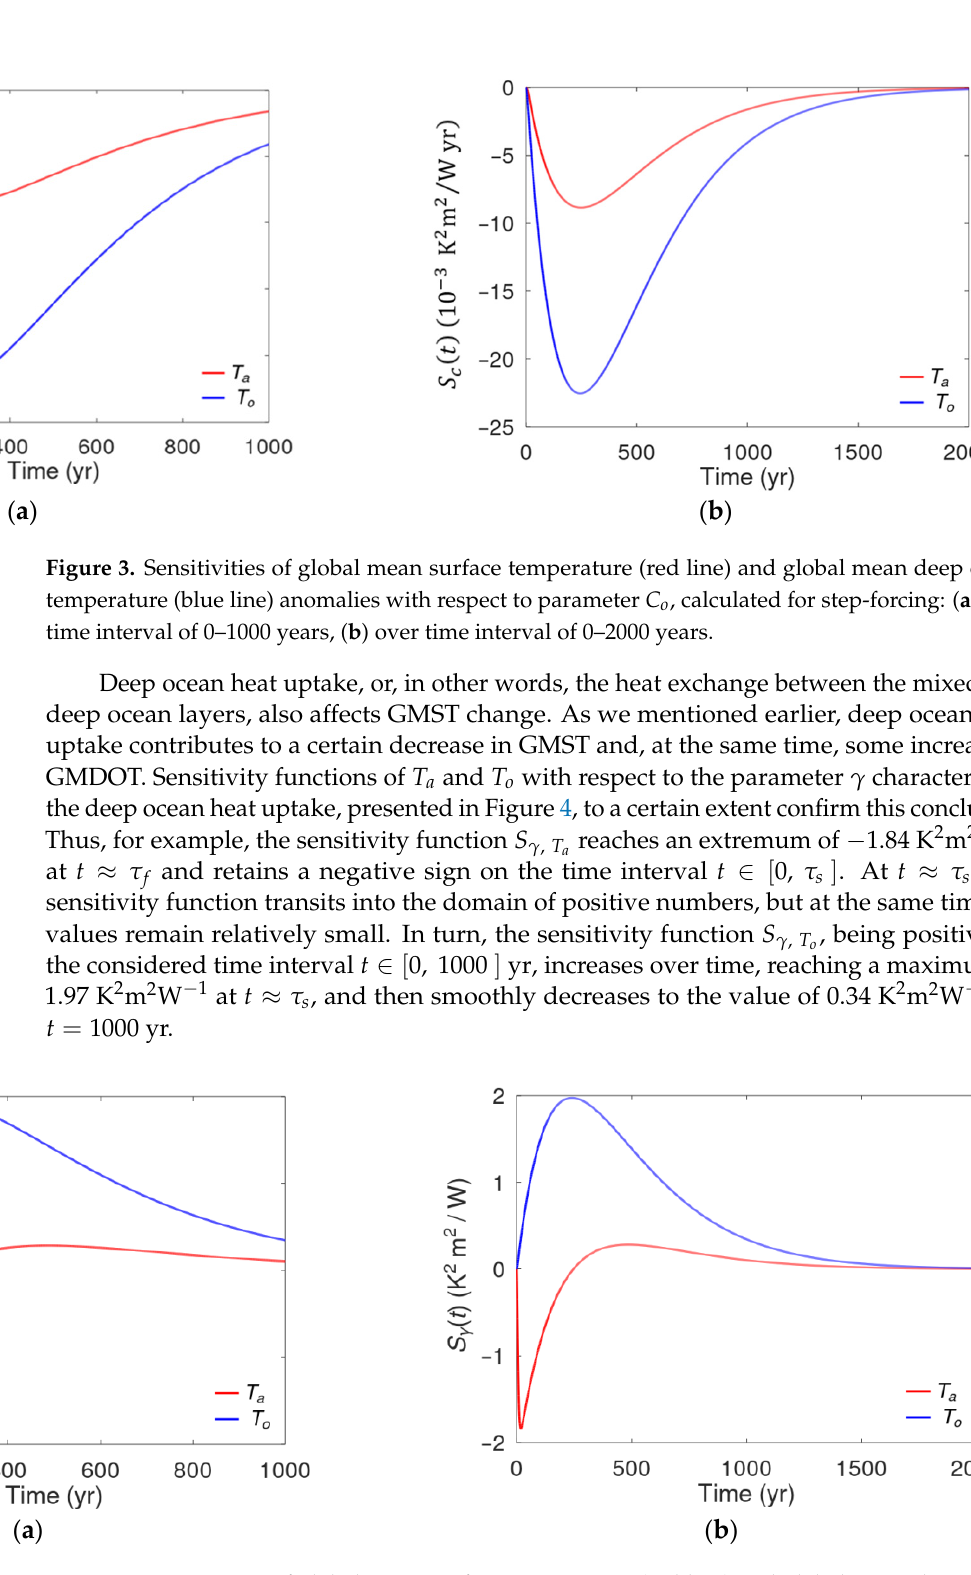
Figure 4. Sensitivities of global mean surface temperature (red line) and global mean deep ocean temperature (blue line) with respect to parameter γ , calculated for step-forcing: ( a ) over time interval of 0–1000 years, ( b ) over time interval of 0–2000 years.